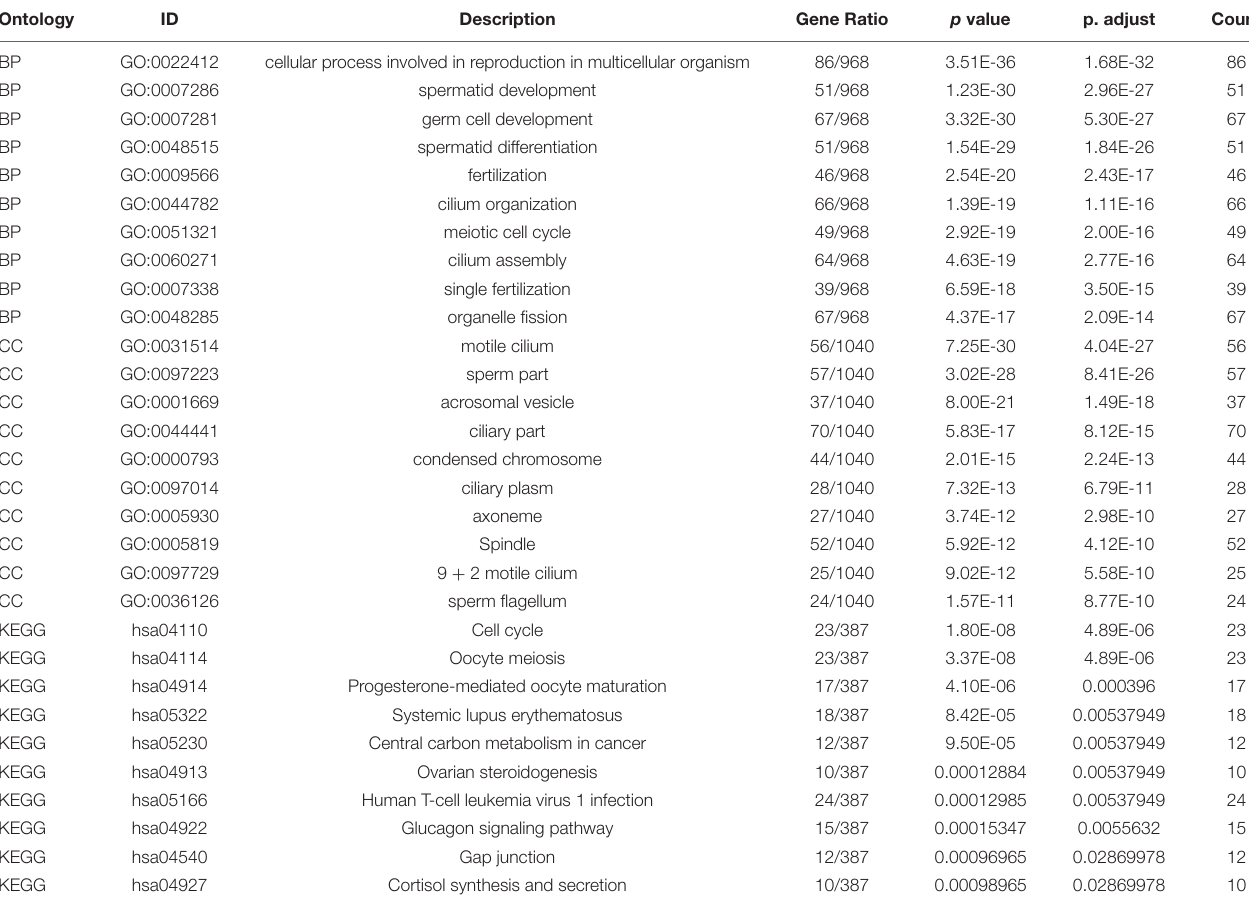
TABLE 1 | Top 10 Enrichment analysis of the